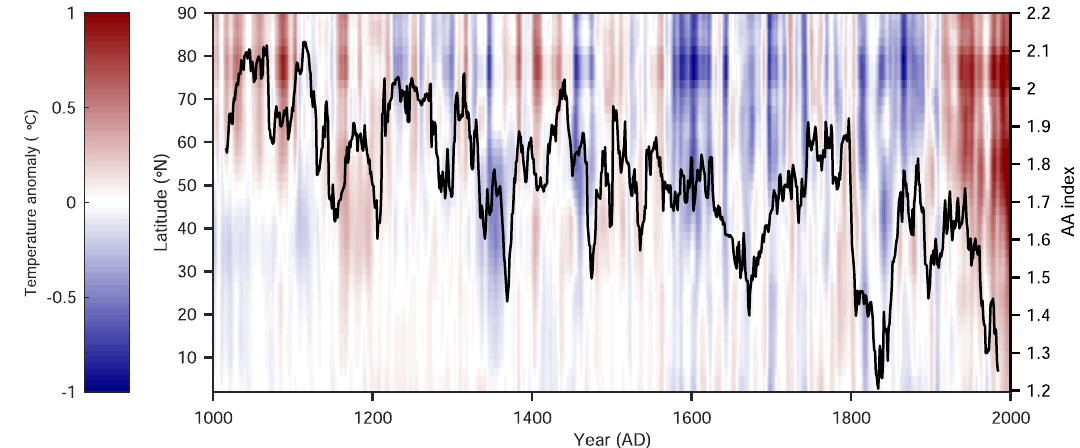
Fig. 2 Annual-mean zonal variability of the temperature anomalies over the NH during the past millennium and the reconstructed AA index. The black line is the reconstructed AA index derived from the PDA-based